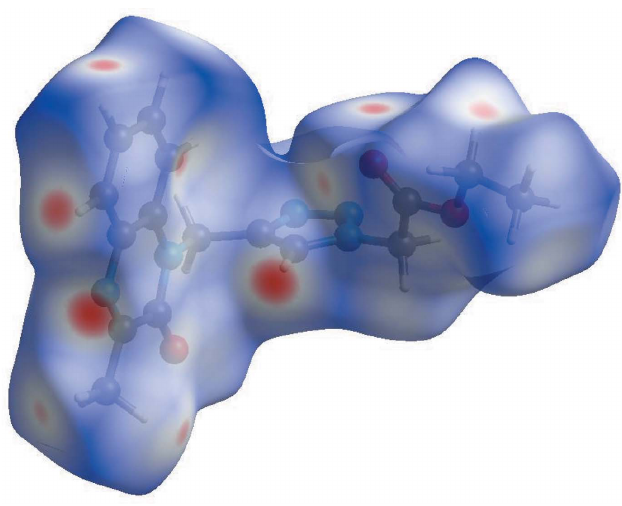
Figure 4 View of the three-dimensional Hirshfeld surface of the title compound plotted over d norm in the range (cid:4) 0.2685 to 1.3470 a.u.